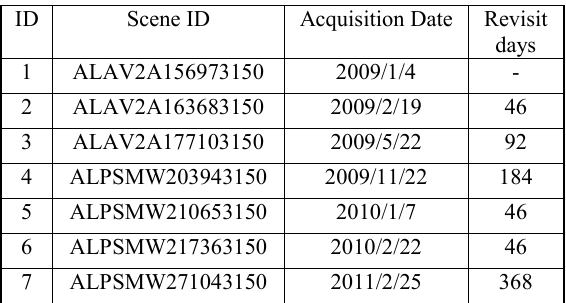
Table 2. Acquisition date of ALOS imagery of ship breaking yards around Chittagong